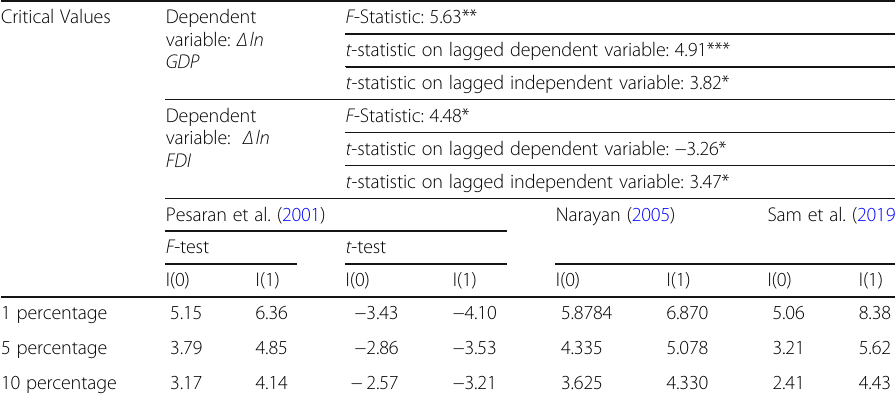
Table 4 Long-run augmented ARDL bounds testing with F -statistic and t -statistic Critical